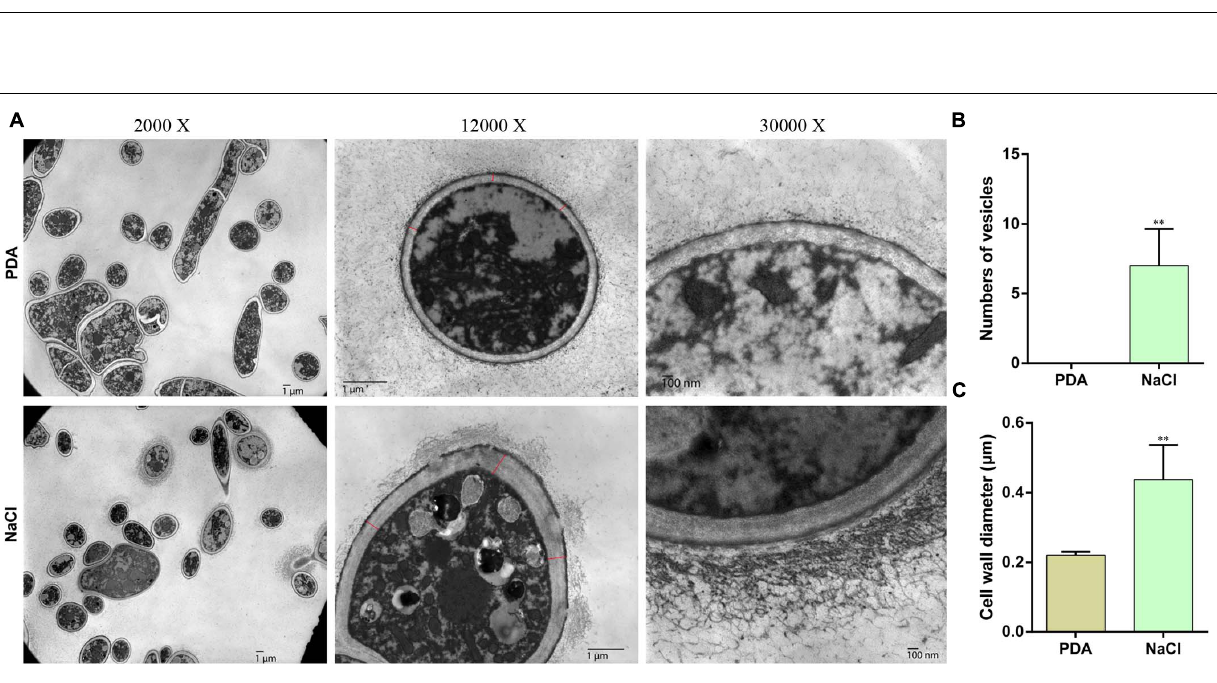
FIGURE 1 | Observation of the Setosphaeria turcica phenotype when cultured under osmotic conditions. (A) Colony morphology and (B) the growth rate of S. turcica in potato dextrose agar (PDA) and 0.4 M NaCl, 0.4 M KCl, and 0.6 M sorbitol culture media. The results are shown as mean colony diameter from three independent experiments. (C) Morphology and (D) the growth rate of aerial hyphae under the above four culture mediums; (E) morphology of basal hyphae under the above four culture conditions. These results are shown as mean length of hyphae from three independent experiments. Data are presented as the mean ± SD of three independent experiments. ** P < 0.01.